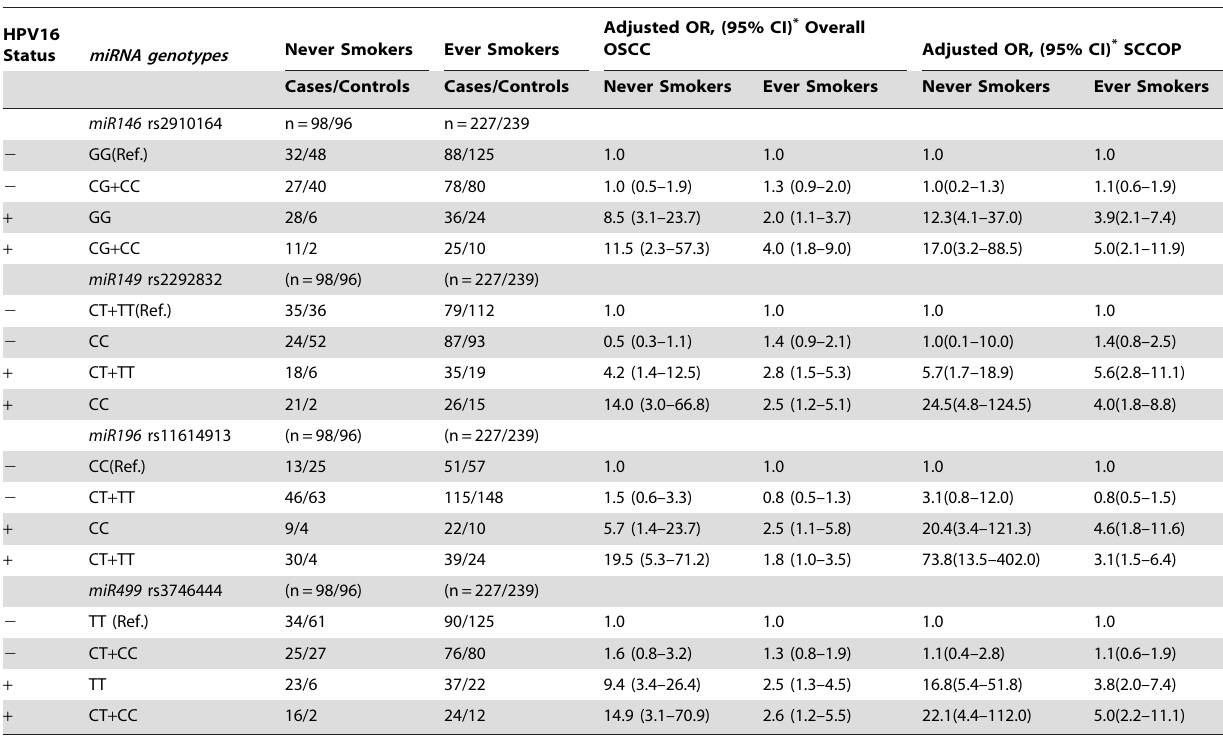
Table 6. Joint Effect of HPV16 Seropositivity and MicroRNA Genotypes on OSCC Risk Stratified by Smoking